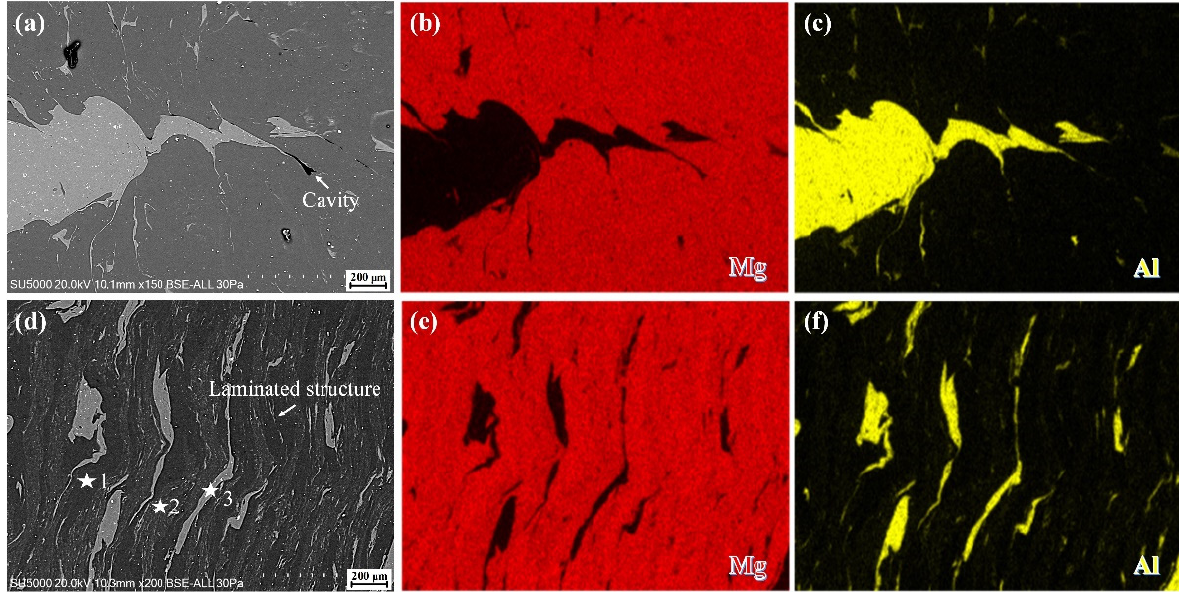
Figure 5. SEM images and EDS mapping of the microstructure in ( a – c ) FSW and ( d – f ) SFSW weld fabricated at 800 rpm.